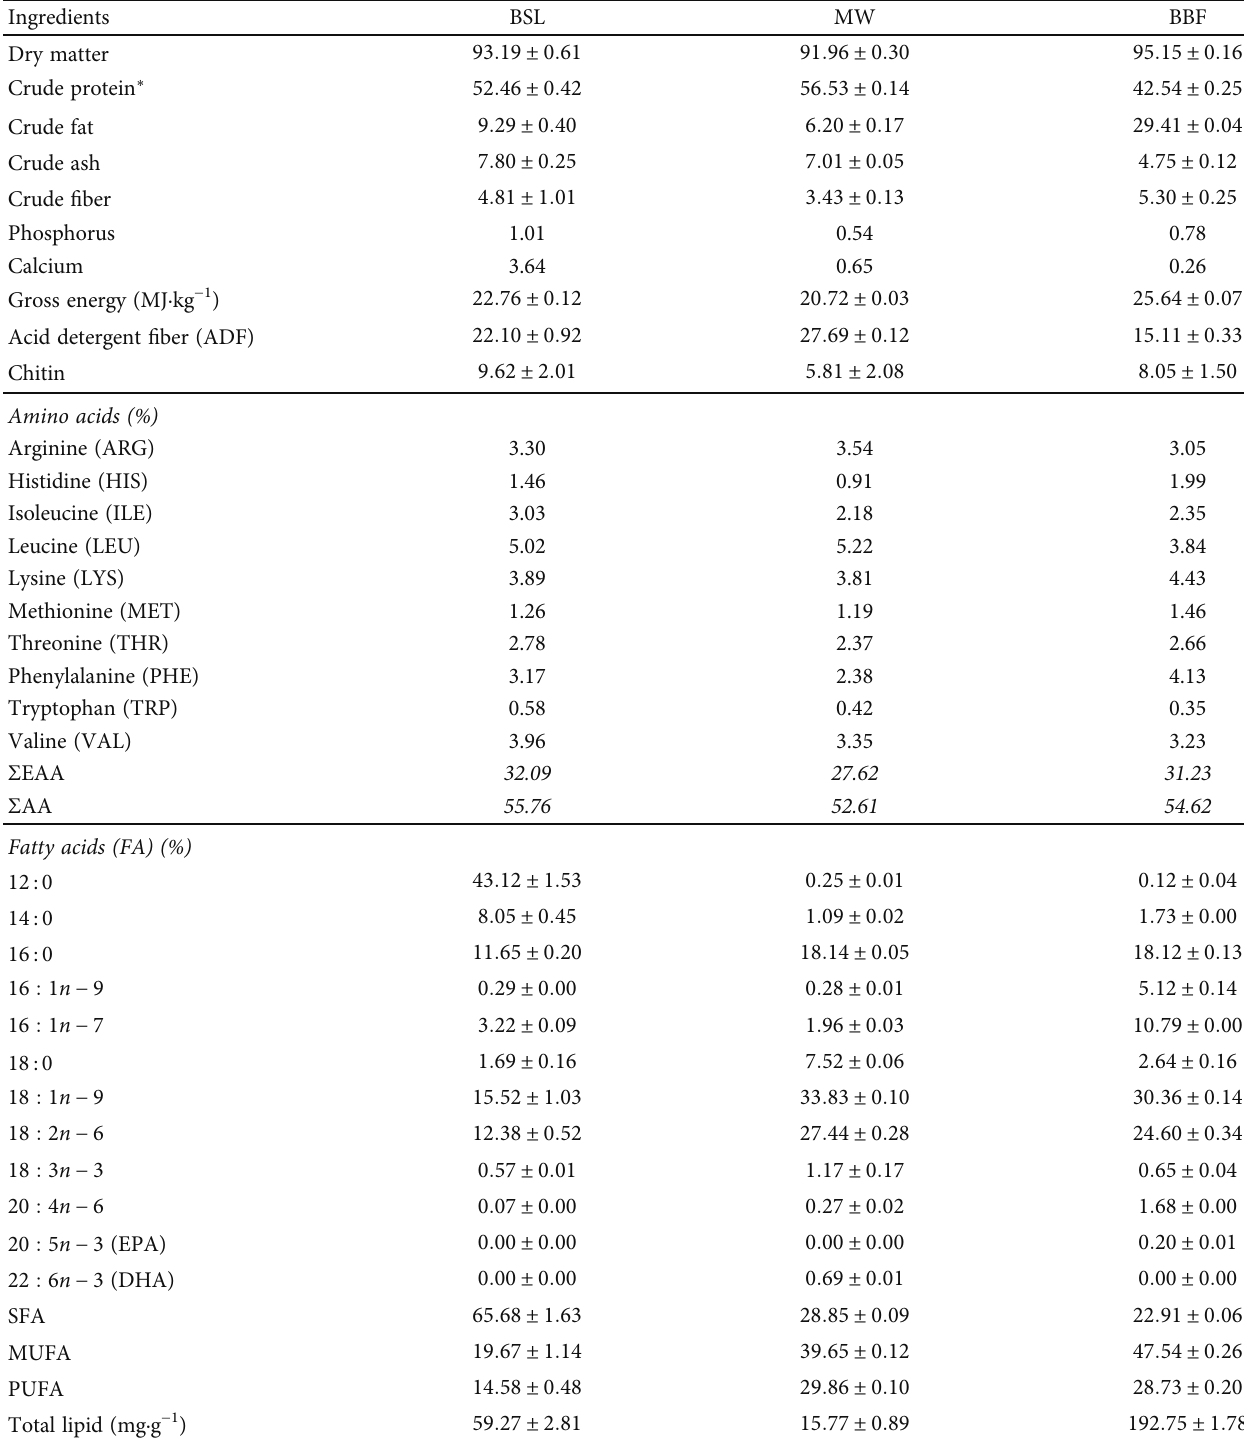
Table 1: Composition of the tested insect meals (dry weight,